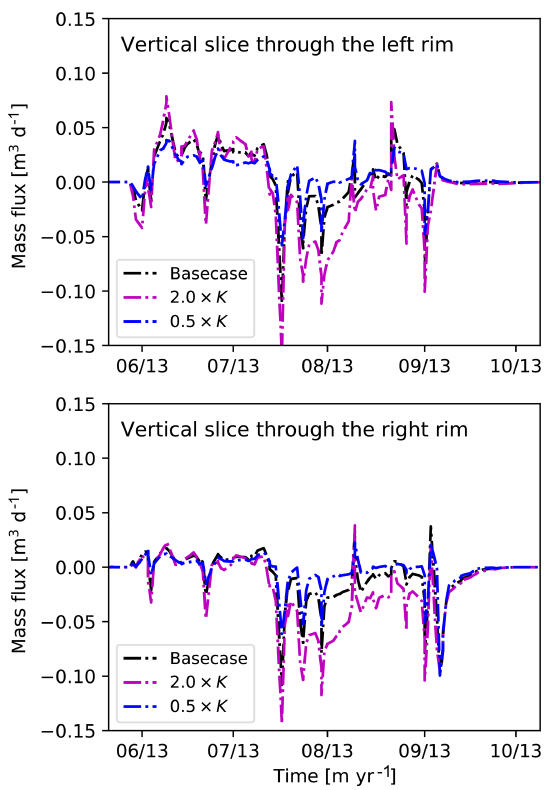
Figure 9. A time series of simulated lateral water fluxes between polygon center and trough through a 50cm (the maximum thaw depth) deep vertical slice at the left and right rims of the polygon. Negative flux indicates inward flow (trough to